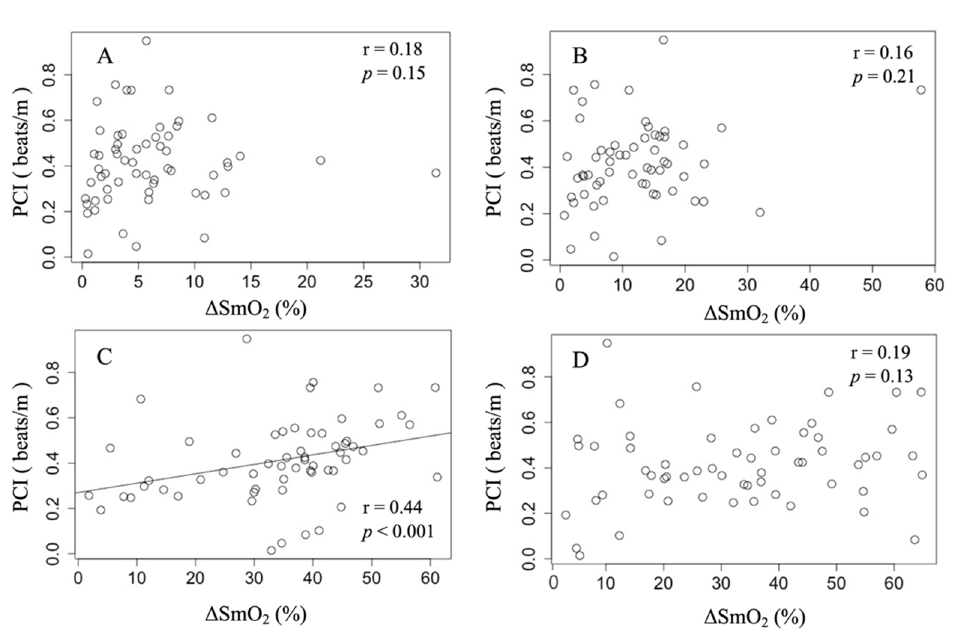
Figure 3. Correlation between PCI and Δ SmO 2 in each muscle. The data were analyzed using Spearman’s rank correlation coefficient. ( A ): No significant differences were found among the PCI and Δ SmO 2 values in the RF of all children (r = 0.18, p = 0.15). ( B ): No significant difference was found among the PCI and Δ SmO 2 values in SS in all children (r = 0.16, p = 0.21). ( C ): There was a significant difference between PCI and Δ SmO 2 in the TA of all children with a moderately positive correlation (r = 0.44, p < 0.001). ( D ): No significant difference was found between PCI and Δ SmO 2 in the GS of all children (r = 0.19, p = 0.13).